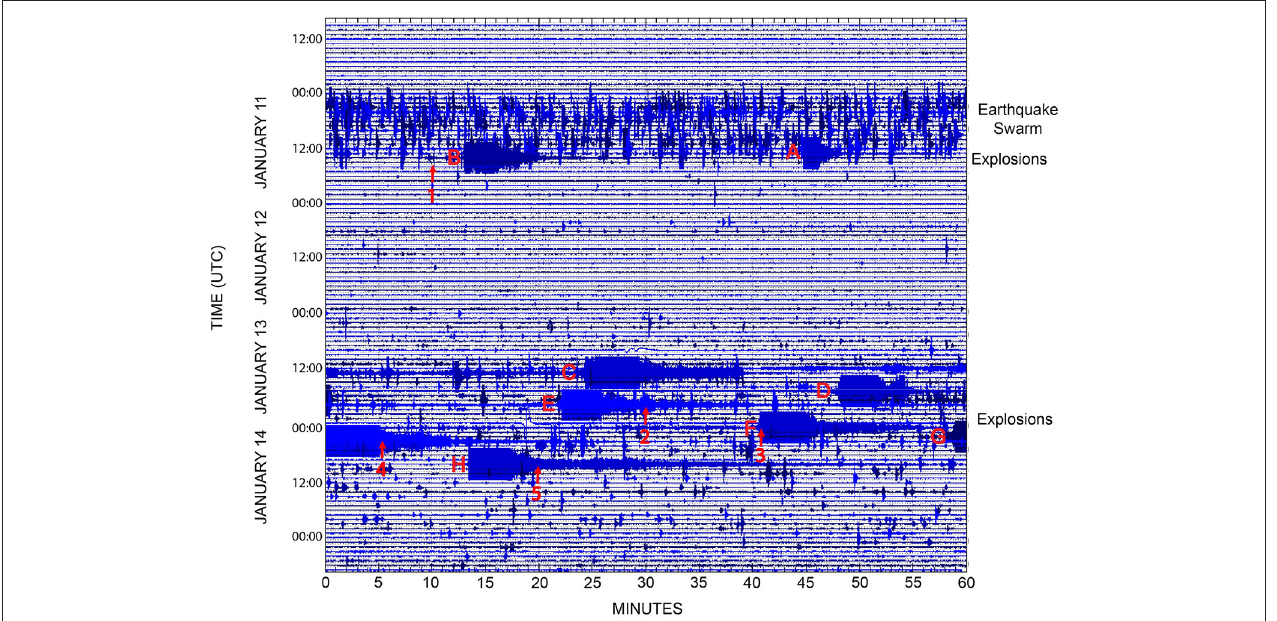
FIGURE 6 | A 5-day velocity seismic record from station AU13 (Figure 4) that shows the eight explosive events that occurred at Augustine Volcano between January 11 and January 14, 2006. Labeled events are explosions that occurred at A, 13:44, B, 14:12, January 11, C, 13:24, D, 17:47, E, 20:22 January 13, F, 03:58, G, 9:14 January 14, 2006. Arrows correspond to time of AVO call down 1, 15:10, January 11, 2, 20:30, January 13, 3, 01:40, 4, 4:05, 5, 00:20 January 14, 2016. Records of call downs do not exist for explosions at 13:24 and 17:47 UTC on January 13, 2016.